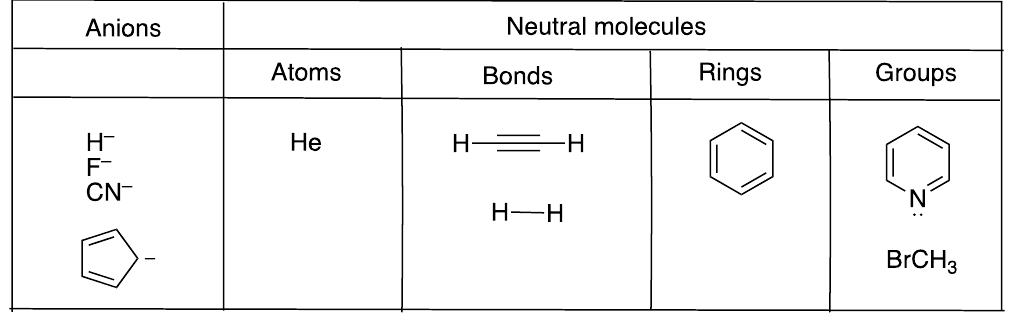
Figure 2. Lewis bases involved in noncovalent interactions.